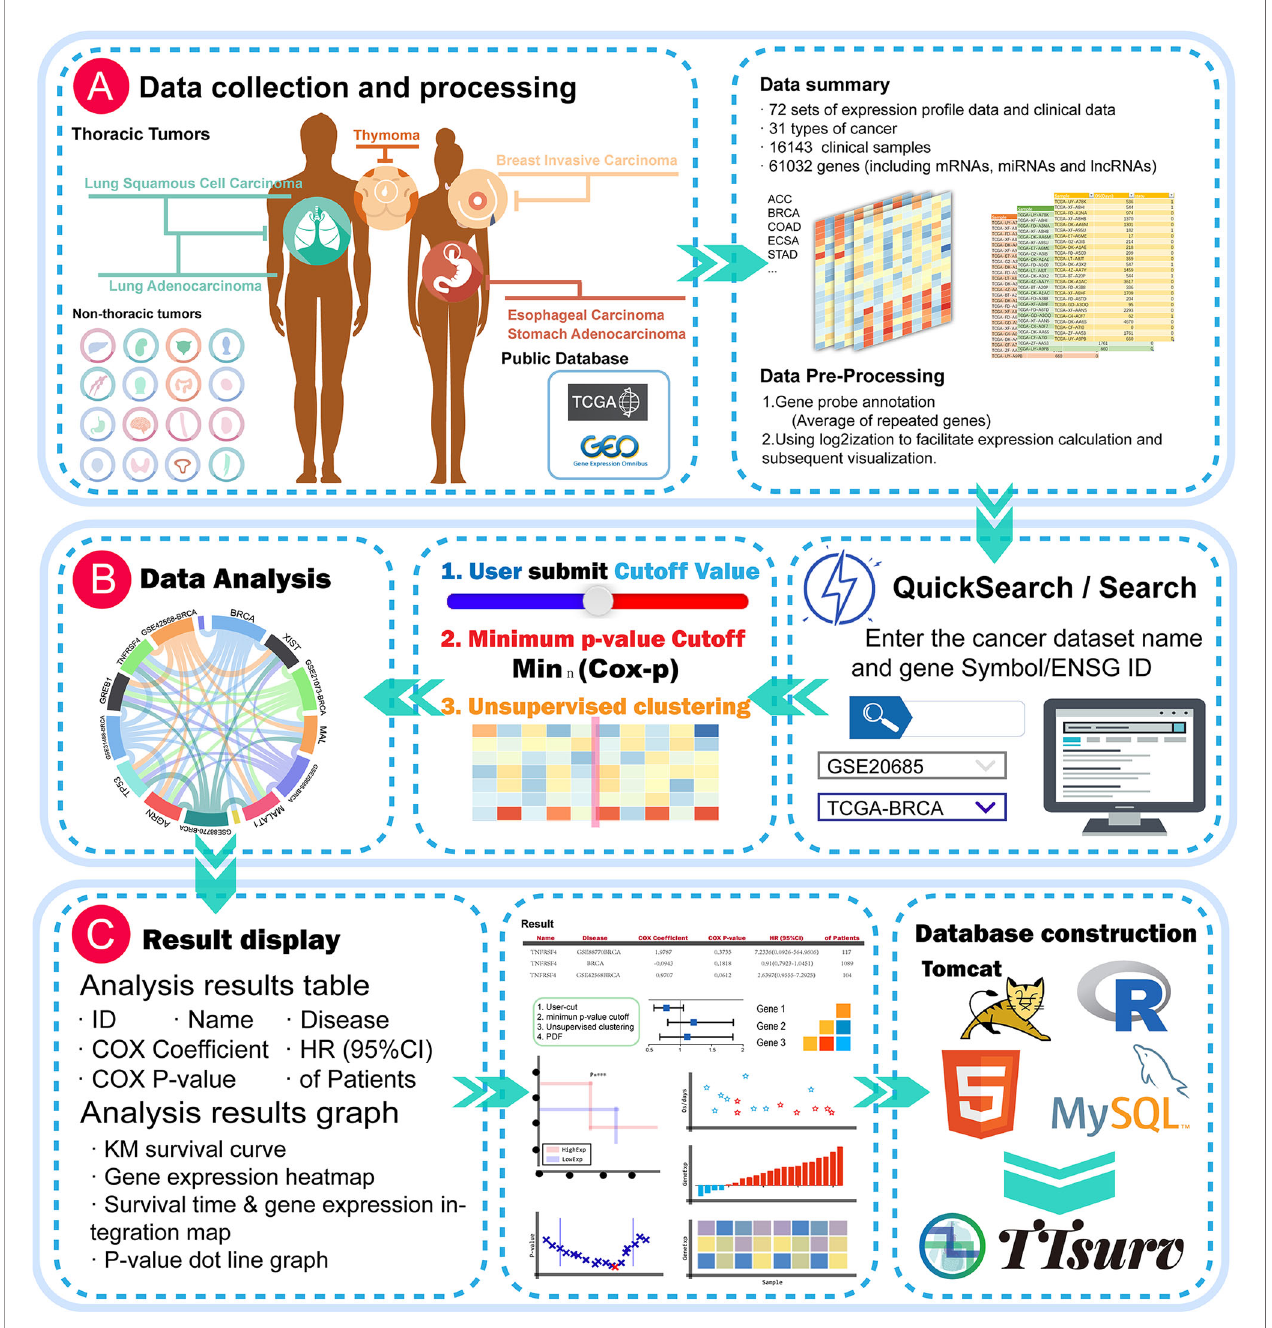
FIGURE 1 | Global view of the TTSurv database. (A) illustrates the data sources and subsequent data processing by TTSurv; (B, C) show the user interface illustrating how the user searches for data and the results obtained; and (C) shows the results provided by TTSurv and its backend